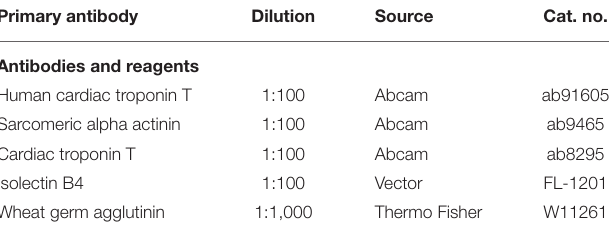
TABLE 1 | The primary antibodies used in the study. Primary